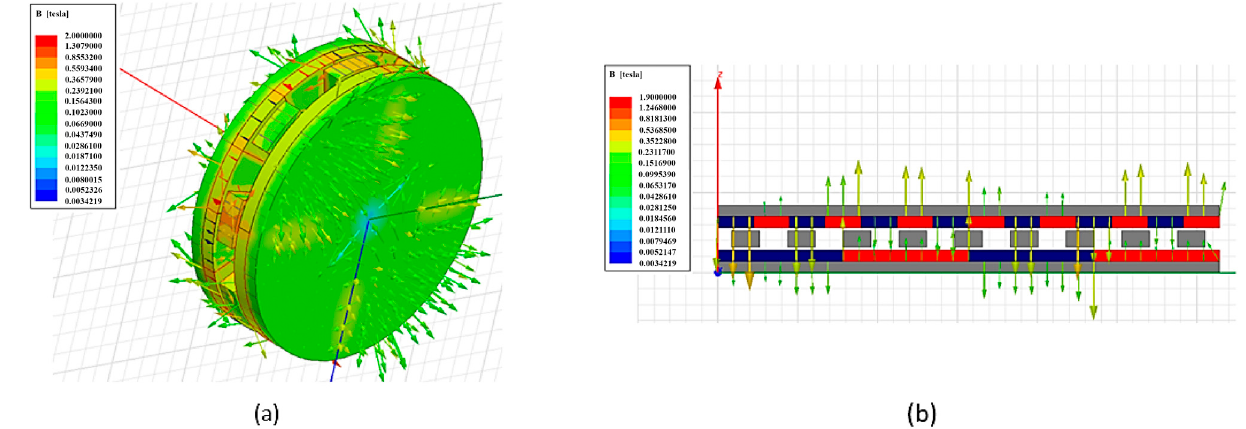
Figure 10. Magnetic flux lines path in a 2D AFMG model.